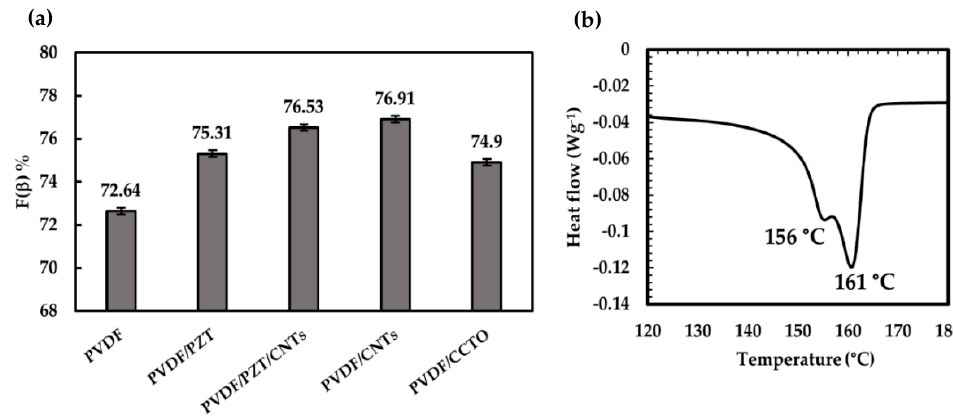
Figure 4. ( a ) Relative fraction of calculated polar β phase. ( b ) DSC curve of PVDF sample.